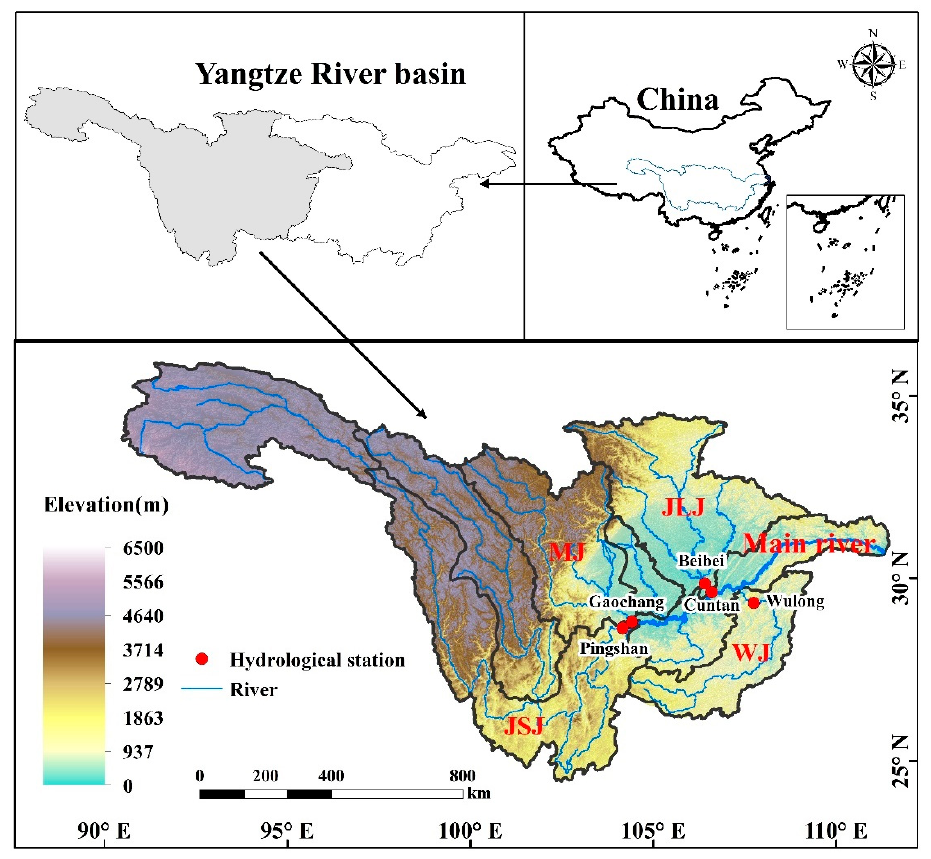
Figure 1. Major tributaries and hydrological stations located in the upper of the Yangtze River (JSJ, Jinshajiang; JLJ, Jialingjiang; WJ, Wujiang; MJ, Minjiang).